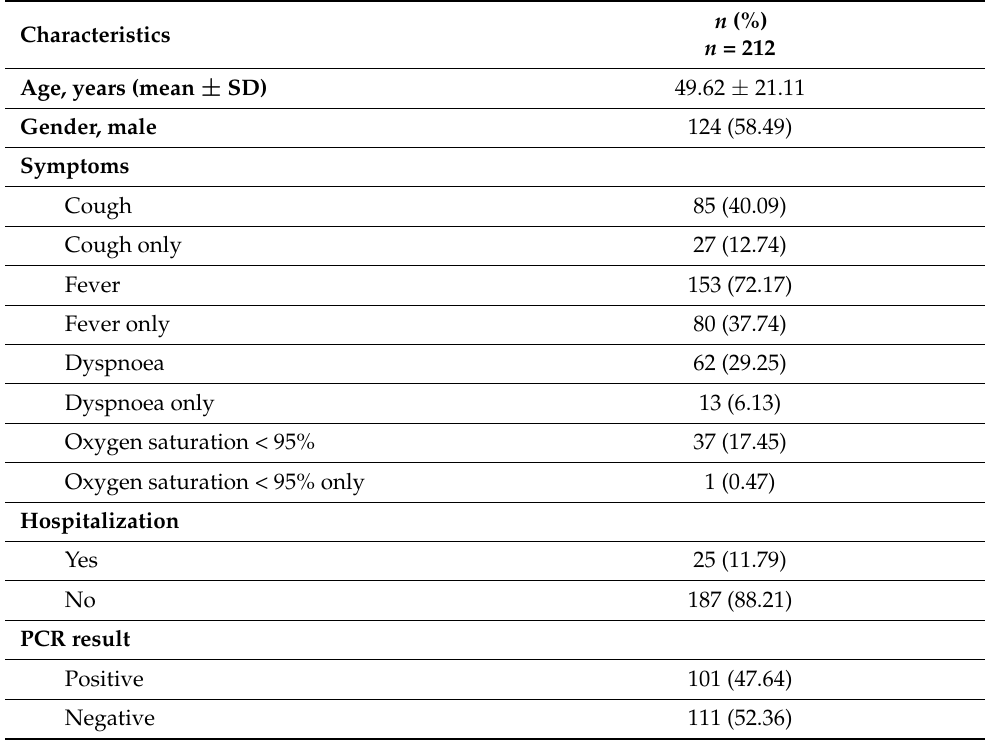
Figure 1. Flow chart documenting participants included in the study. Table 1. Patient demographic and clinical variables.